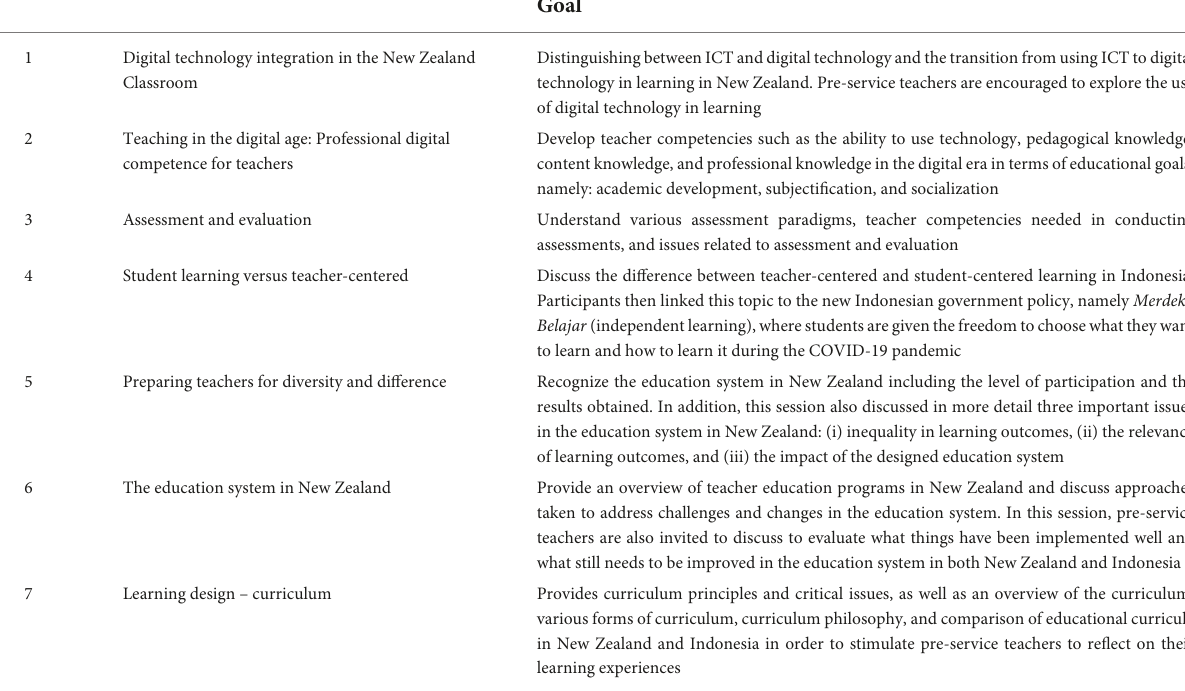
TABLE 3 Activities in pre-service teacher training